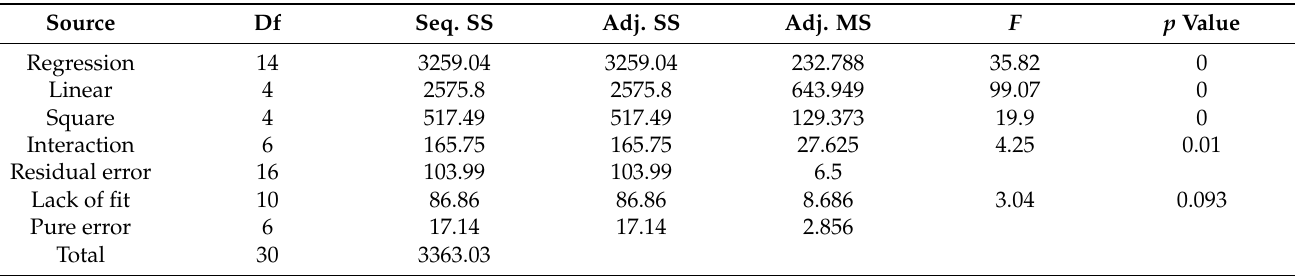
Table 4. Analysis of variance (ANOVA) for MO degradation by means immobilized consortium obtained using